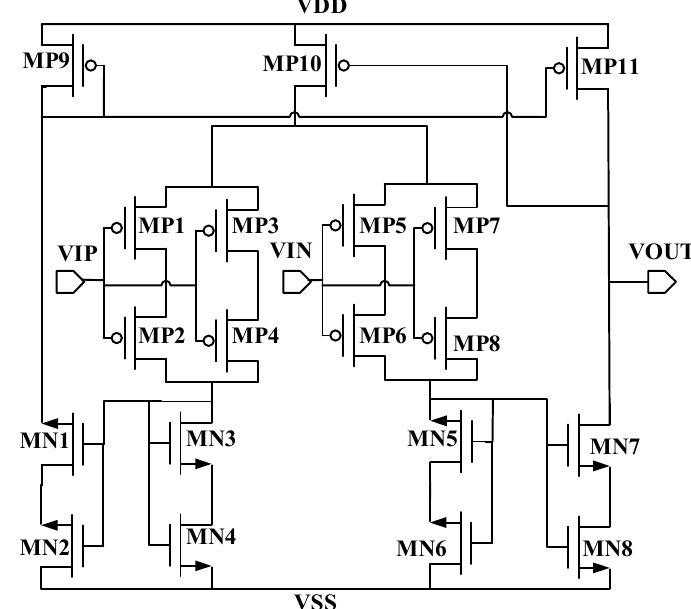
Figure 4. Differential operational amplifier (OP).